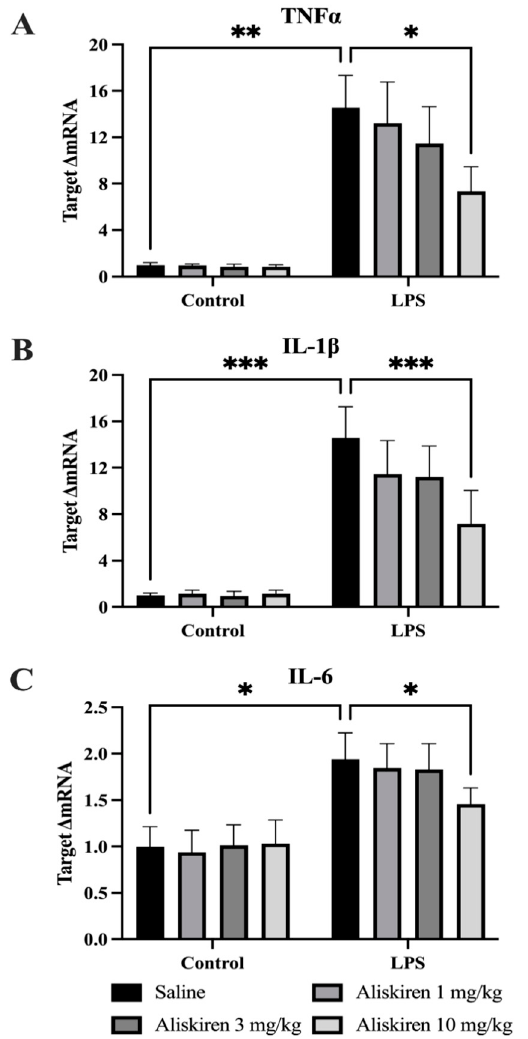
Figure 5. Assessment of Aliskiren Effects on Proinflammatory Cytokines in Prefrontal Cortex. ( A ) The effects of Aliskiren on LPS-induced upregulation of TNF α . ( B ) The effects of Aliskiren on LPS- induced upregulation of IL-1 β . ( C ) The effects of Aliskiren on LPS-induced upregulation of IL-6. n ≥ 6 mice/group. * p < 0.05; ** p < 0.01; *** p < 0.001.